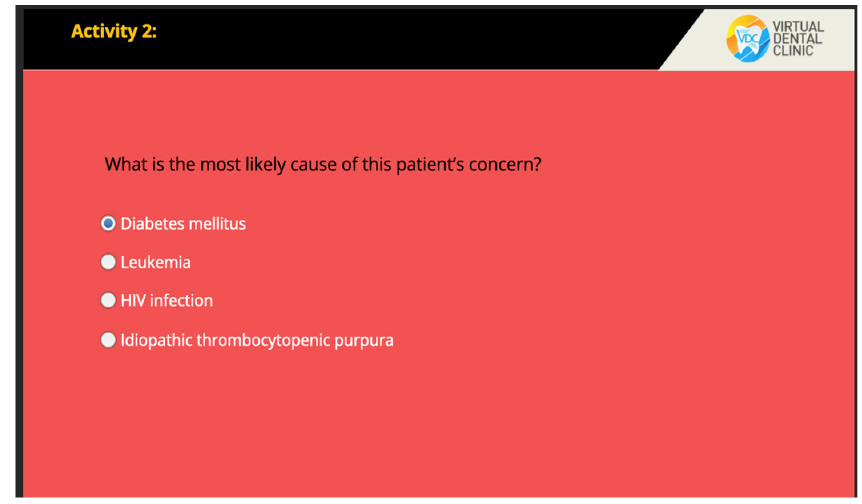
Figure 3. Self-assessment